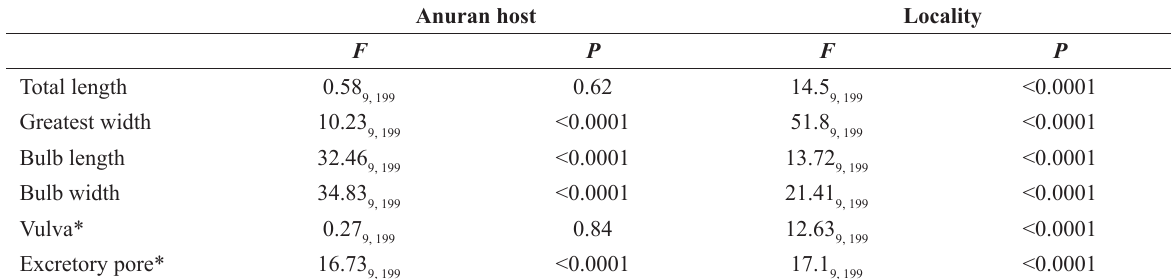
Summary of one-way analysis of variance of females of A. hylambatis between morphological characters and anuran hosts and localities.